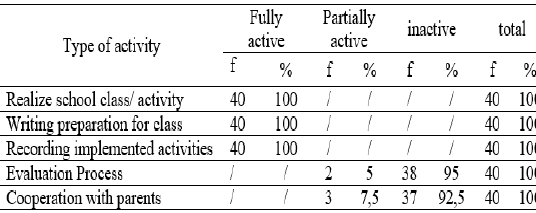
Table 3. Activation of students during